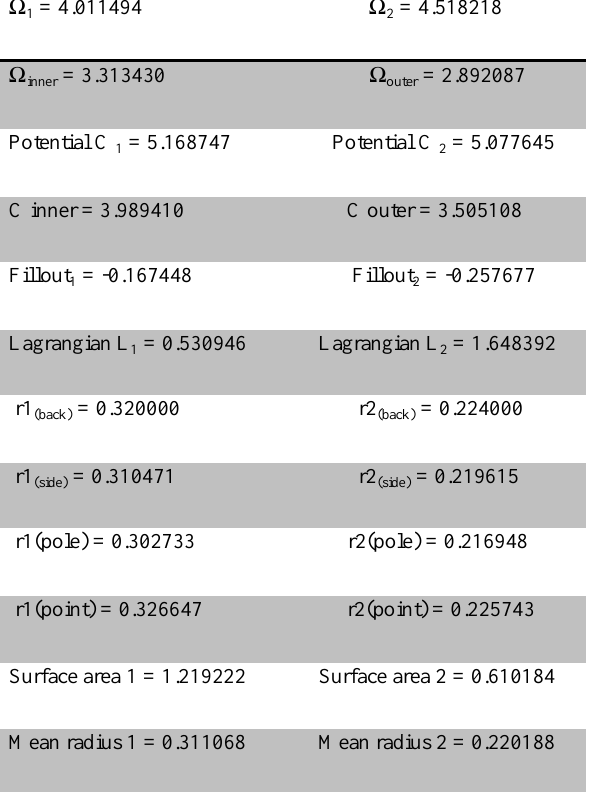
Fig.16: The shape of the spotted Model of BH Vir binary star at different phases. Table 5: The output from Binary Maker 3 of binary RT